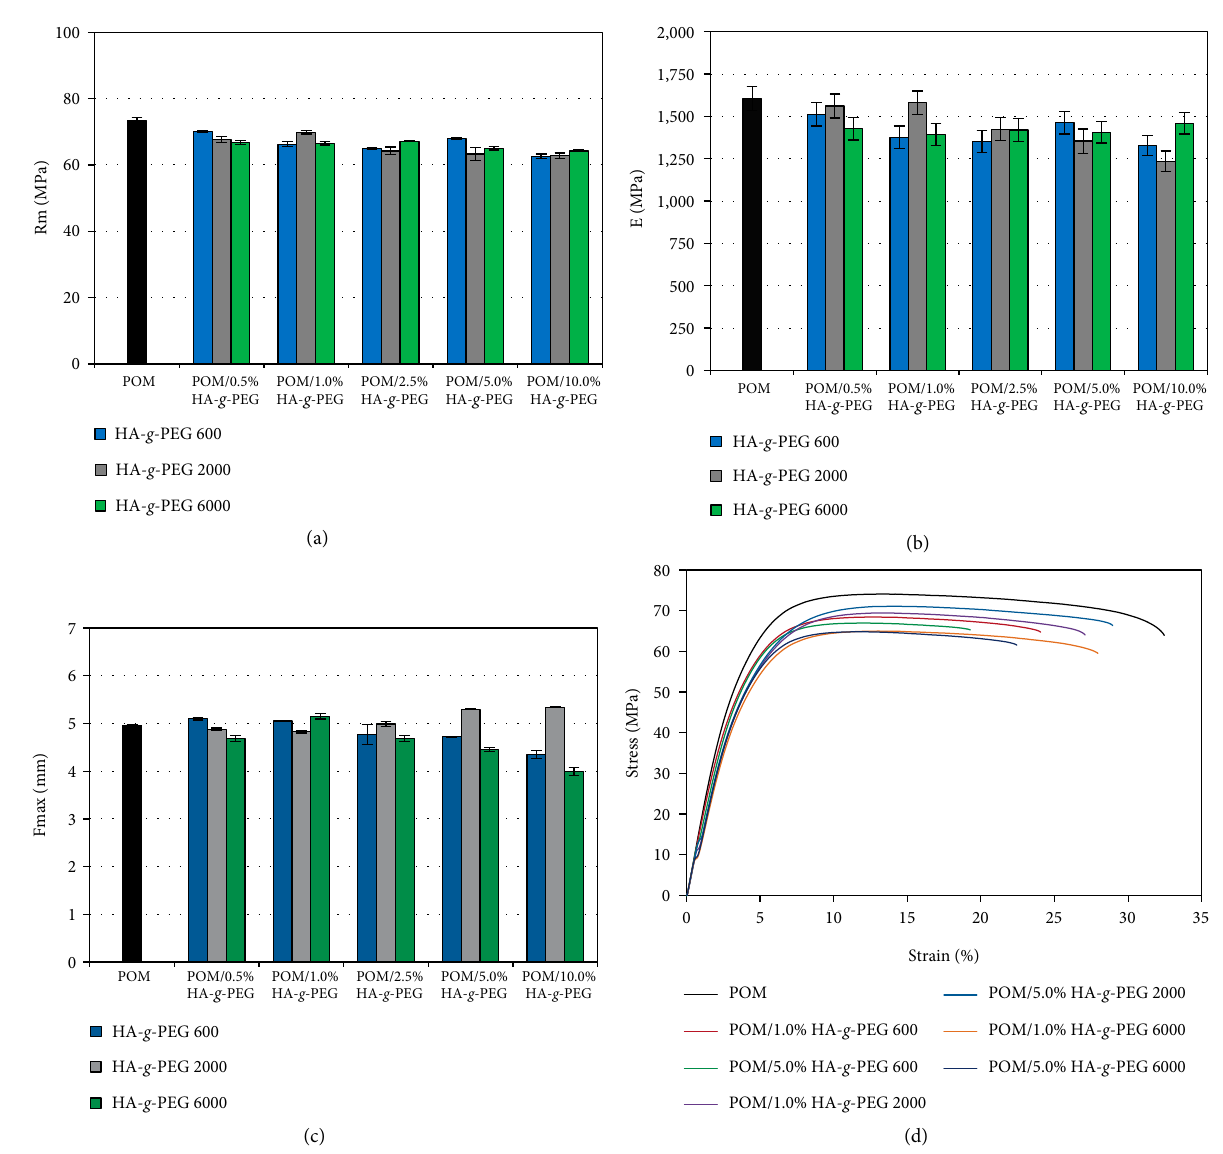
Figure 7: Tensile strength (a), Young modulus (b), elongation at break (c), and stress-strain curves (d) of POM/HA- g -PEG